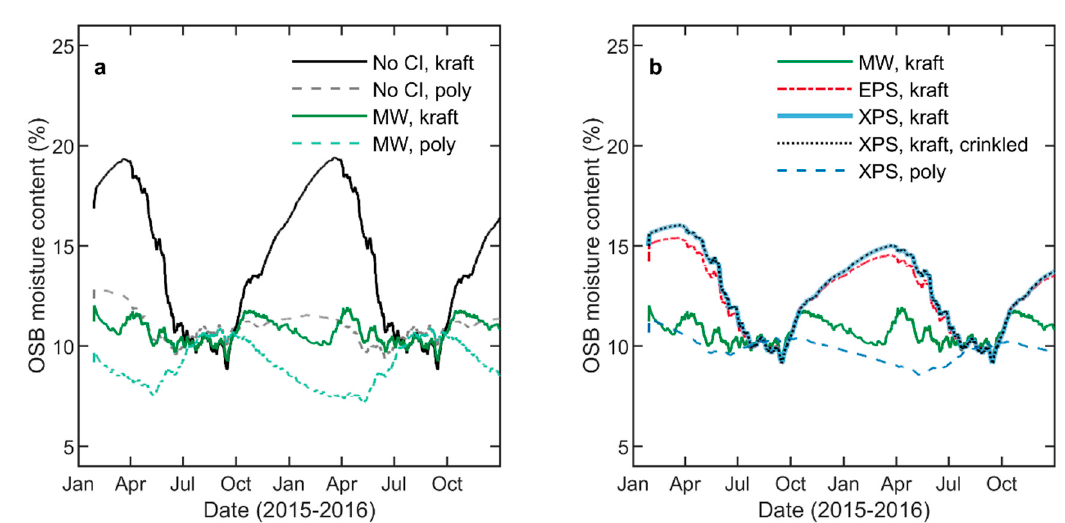
Figure 8. Simulated moisture content in OSB of all north walls using improved material properties: ( a ) No Cl and MW, ( b ) MW, EPS, and XPS.